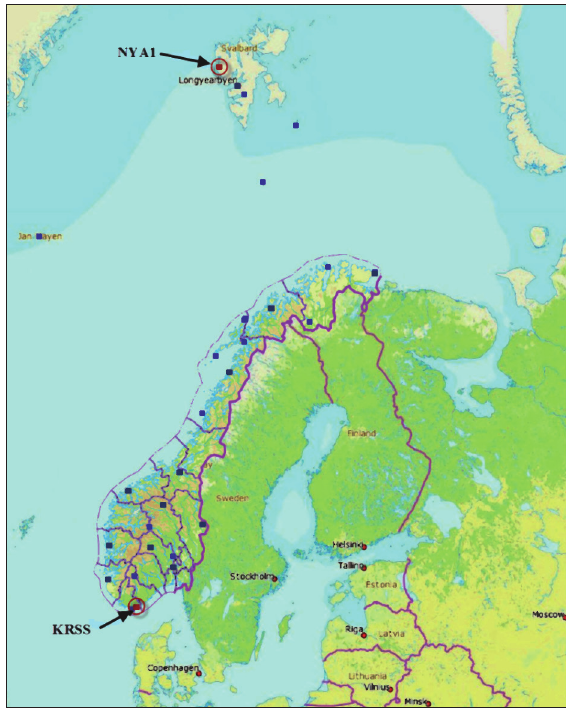
Fig. 1. CPOS station located in Norway. Station NYA1 is located in northern Norway and station KRSS is in southern